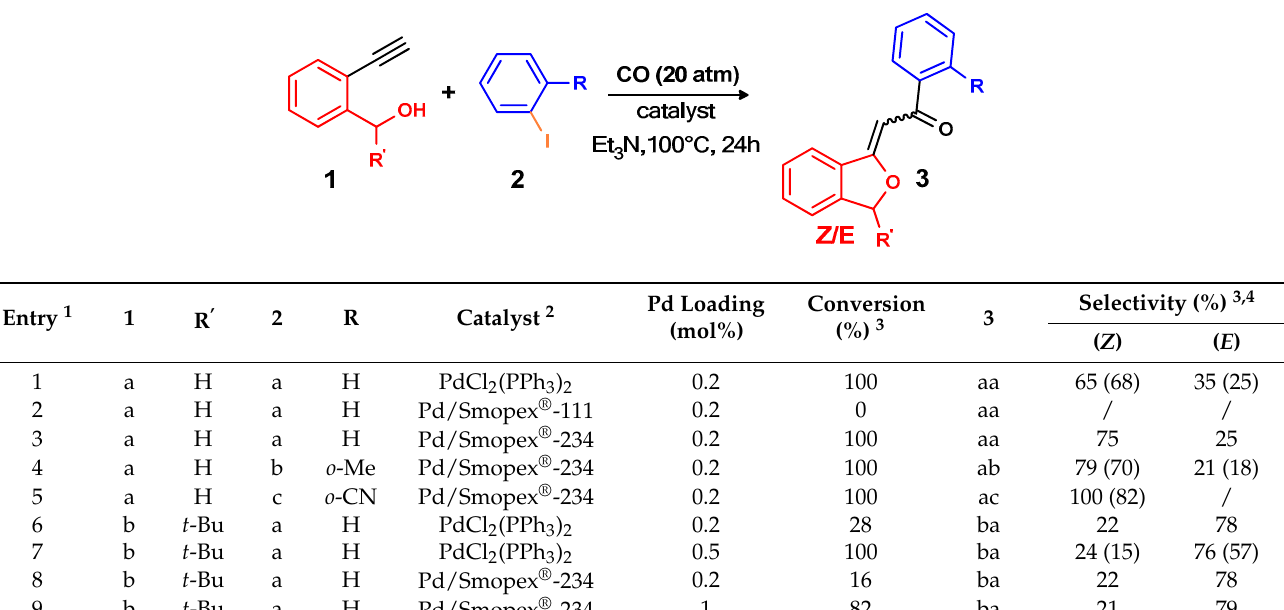
Table 1. Palladium - promoted synthesis of phthalans via cyclocarbonylative Sonogashira Table 1. Palladium-promoted synthesis of phthalans via cyclocarbonylative Sonogashira reactions.